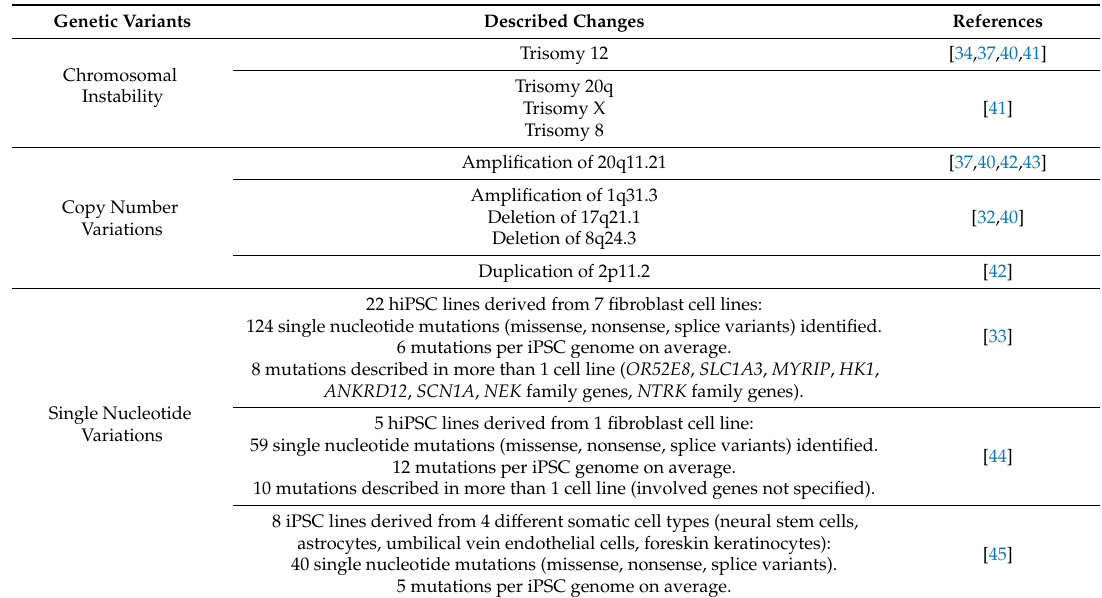
Table 1. Genetic variants identified in